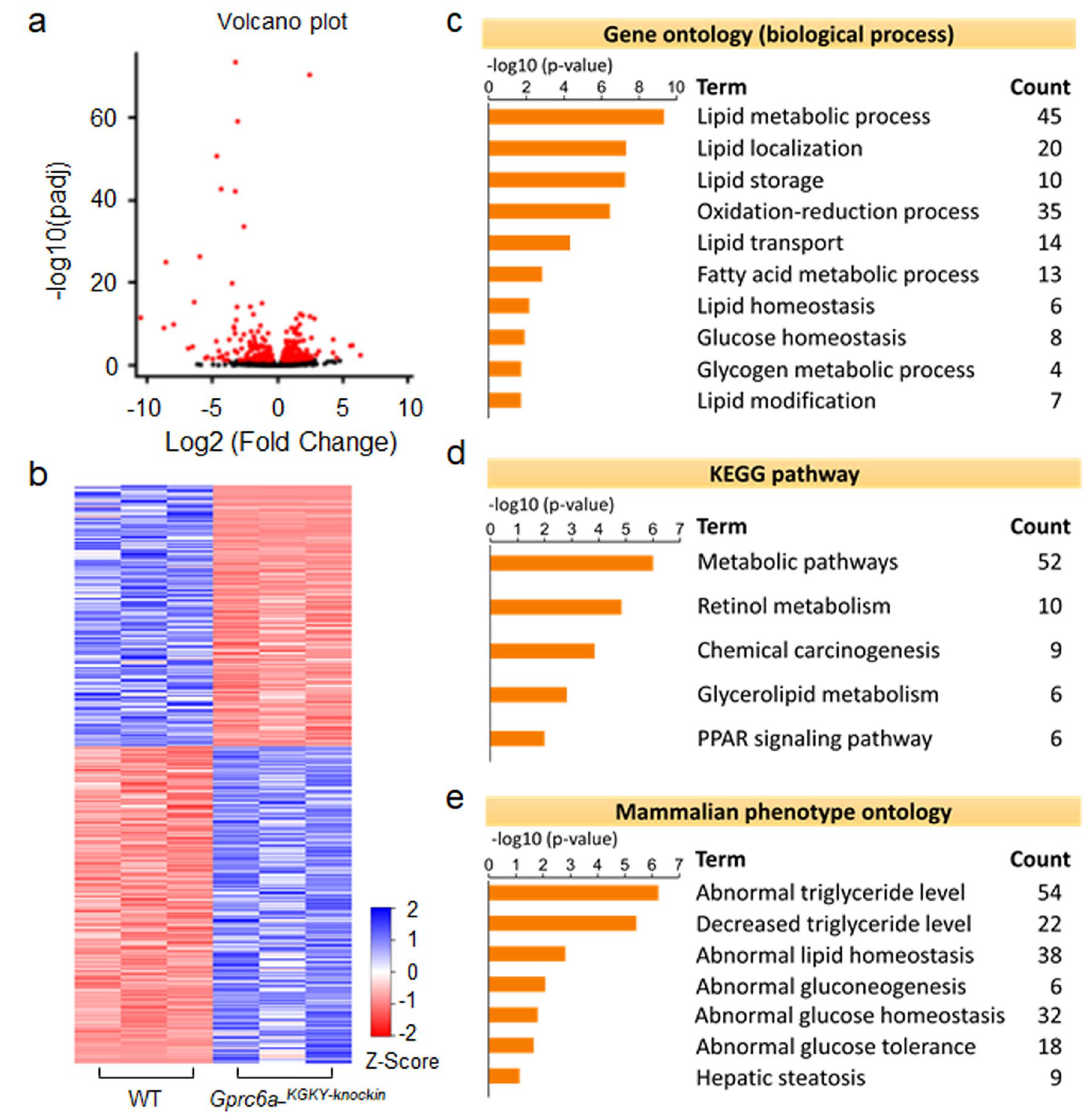
Figure 6. Hepatic gene expression in the liver of Gprc6a- KGKY-knockin mice. (A and B) Volcano plot ( a ); Heat map ( b ) of regulated genes between WT and Gprc6a- KGKY-knockin mice. Blue and red colors indicate high and low gene expression, respectively. Volcano plot and heat map visualization of the hepatic transcriptome demonstrated distinct differences between WT and Gprc6a- KGKY-knockin mice. ( c – e ) Gene ontology ( c ), the Kyoto Encyclopedia of Genes and Genomes pathway (KEGG) ( d ) and Mammalian phenotype ( e ) in the liver of Gprc6a- KGKY-knockin mice. The top rank ordered processes, maps and networks are based on statistical